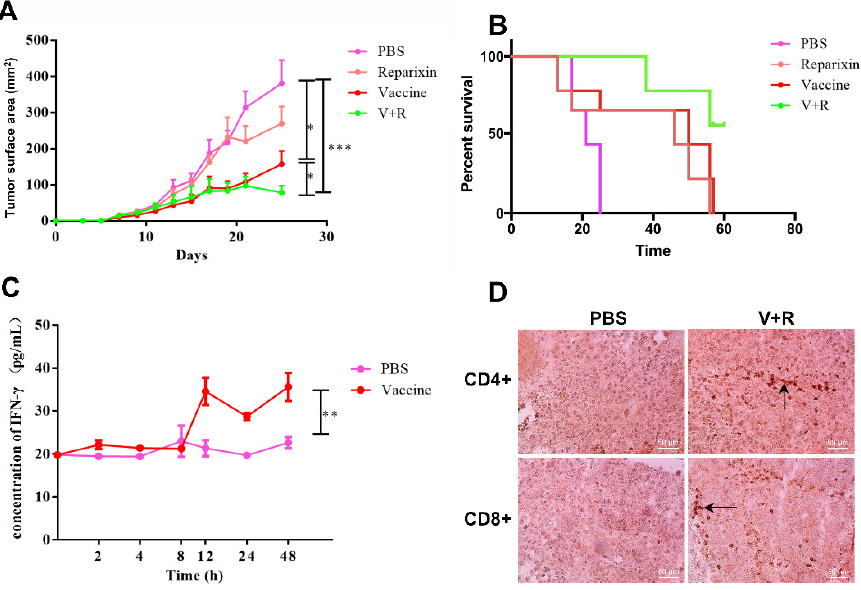
Figure 5. In vivo antitumor effects of Aza-BFcell-106 and a combination of Aza-BFcell-106 and reparixin. ( A ) Tumor volumes and ( B ) survival curves of C57BL/6 mice implanted subcutaneously with melanoma cells are shown. ( C ) IFN- γ levels were measured at 2, 4, 8, 12, 24, and 48 h post-treatment with Aza-BFcell-106. Data are shown as the mean ± SD ( n = 6) of one representative experiment. ( D ) T cells (arrows) infiltrating into tumor tissues after Aza-BFcell-106 treatment are shown. Representative images show the staining for CD4 and CD8. The intensity of CD4 and CD8 staining was also measured. * p < 0.05; ** p < 0.01; *** p < 0.001.